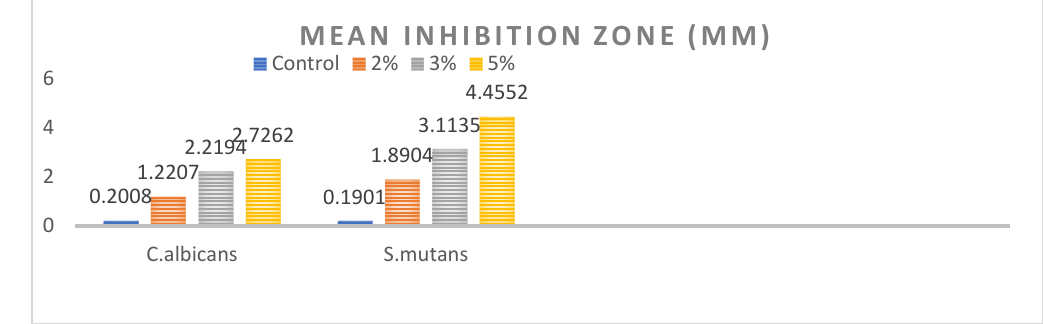
Figure 4 : Mean inhibition zone for S. mutans and